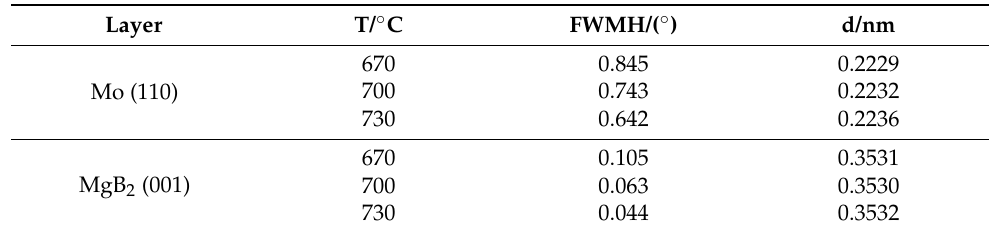
Figure 1. XRD patterns of ( a ) MgB 2 /Mo [24] and ( b ) TiN/SiC [68] multilayer films deposited at different temperatures. The crystallinity of multilayer films is enhanced with increasing temperature. Reprinted with permission from [24] Rare Metal Materials and Engineering 2019, [68] Elsevier 2018. Table 1. The FWHM and interplanar spacing data obtained from the XRD curves of MgB 2 /Mo multilayer films prepared at different temperatures [24].